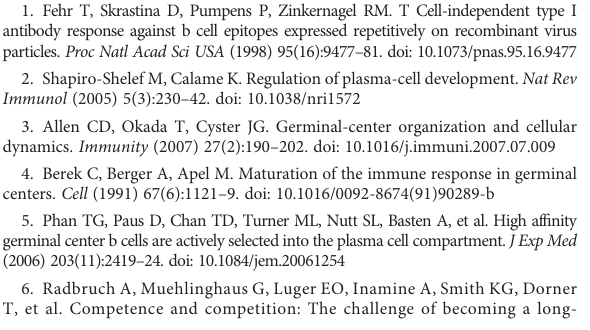
SUPPLEMENTARY TABLE 2 List of used sgRNAs.